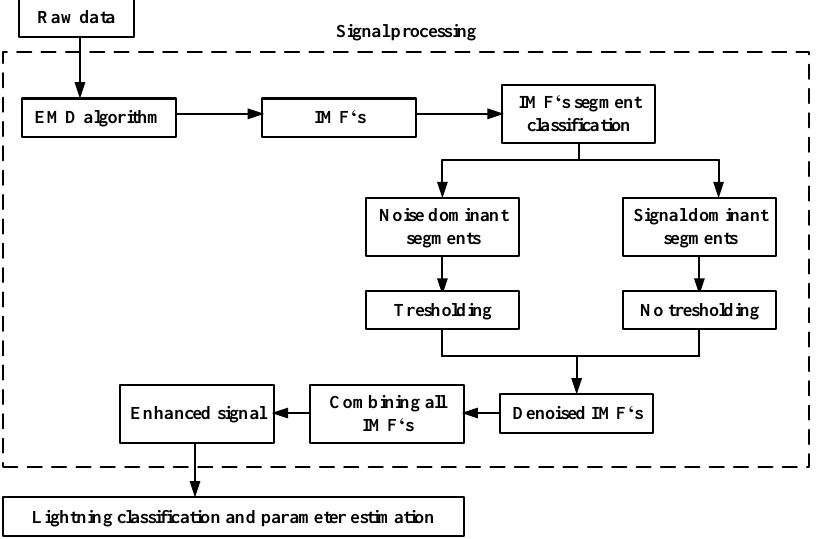
Figure 5. EMD-based adaptive lightning current enhancement and parameter determination system.